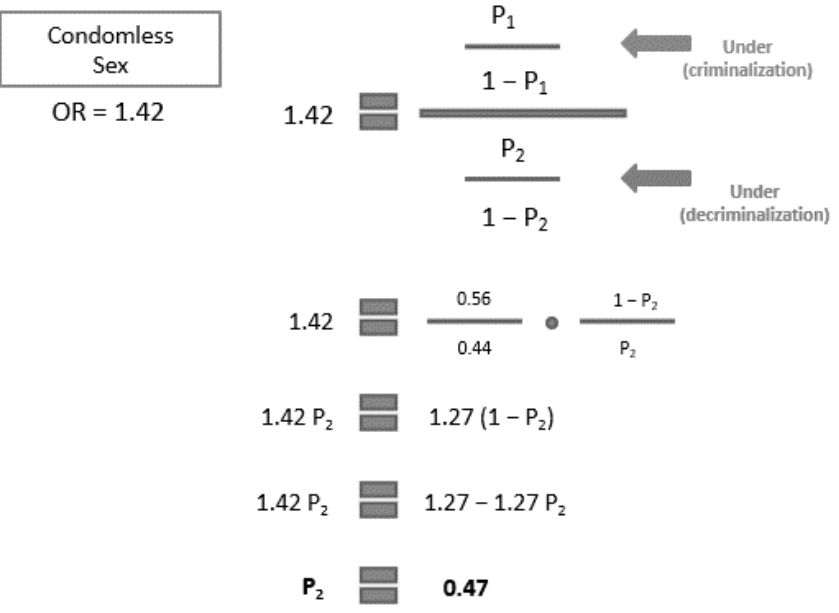
Figure A3. Current incidence of HIV, gonorrhea, and herpes. Figure A4. Probability tree of sex worker’s risk of infection.